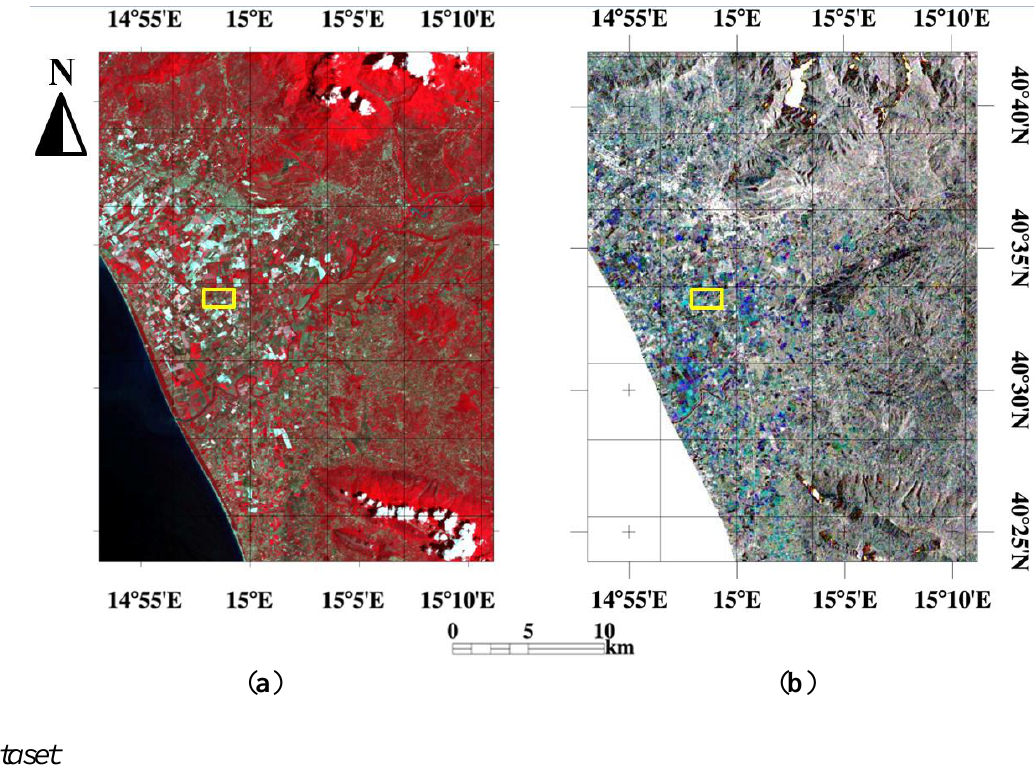
Figure 1. Test site: ( a ) StripMap-PingPong  ° color composite (R: 5 September, HV G: 19 August, B: 3 August; ( b ) CIR image (color infrared composite-near-infrared (NIR), red, green) of 15 August. The rectangle locates the Improsta farm within the Sele